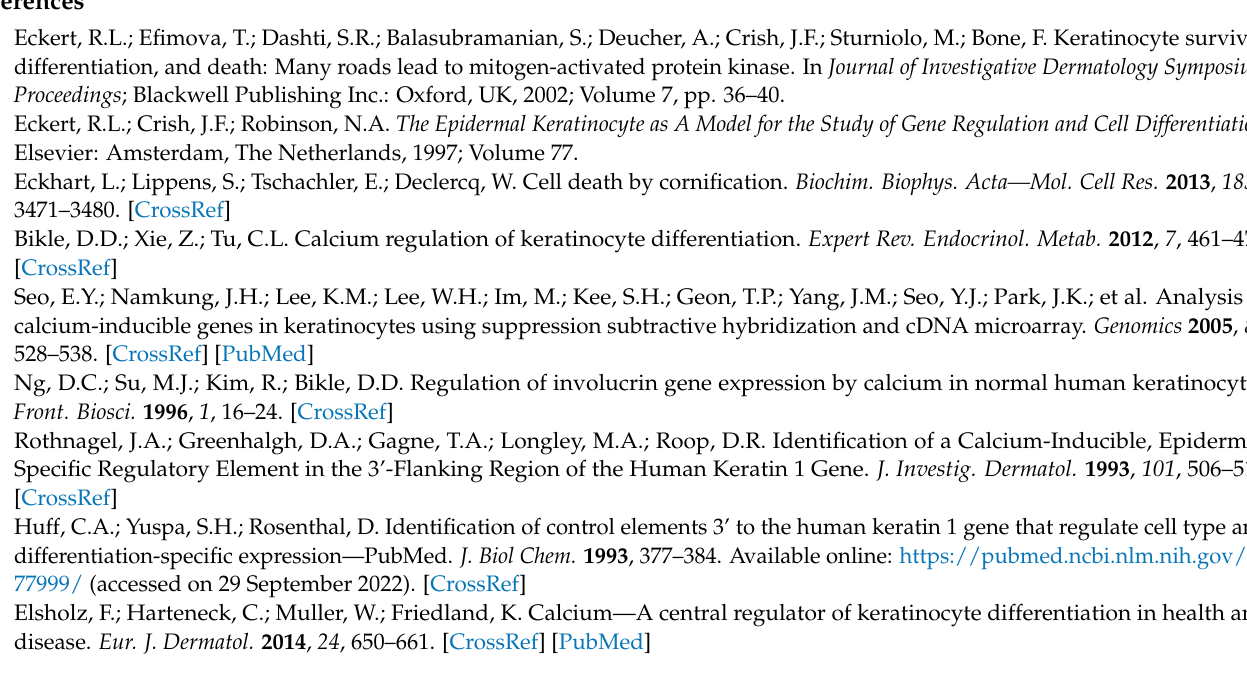
Figure S2: Flow cytometry analysis of CK14 and involucrin expression at day 4 post-calcium